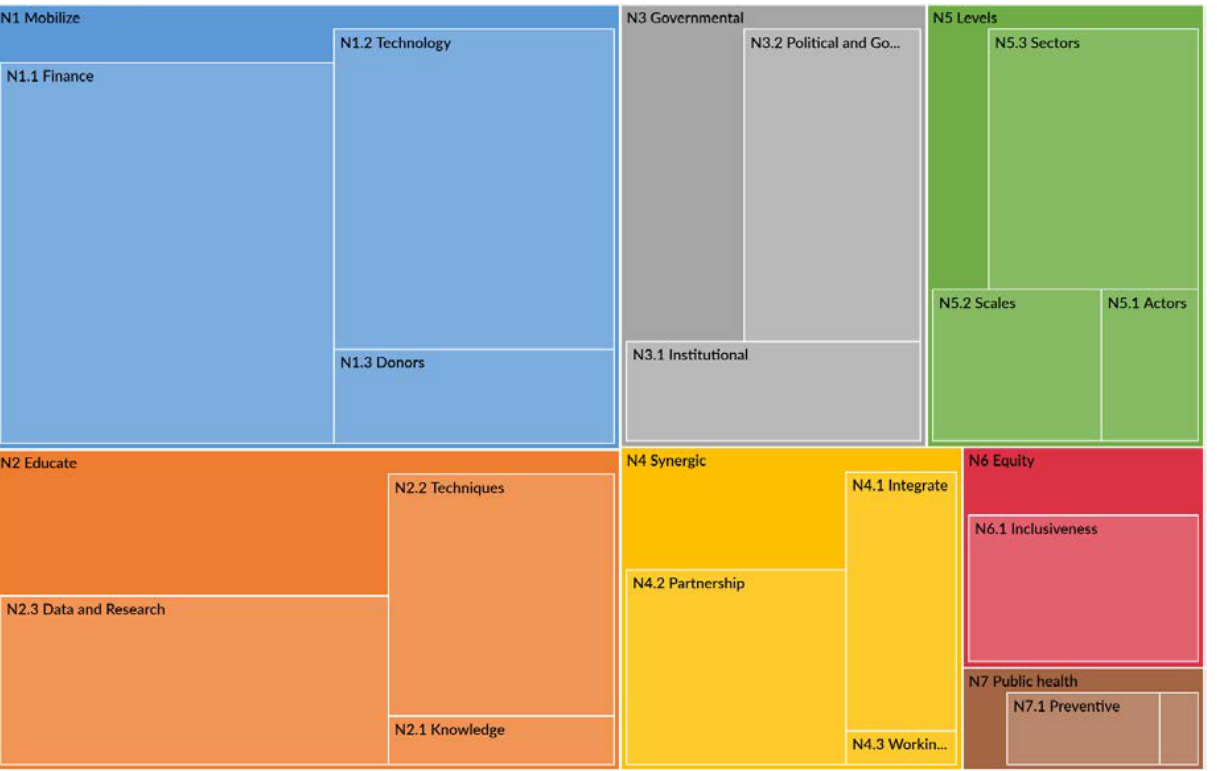
Figure 3. Hierarchy of needs: large area indicates more coding references from